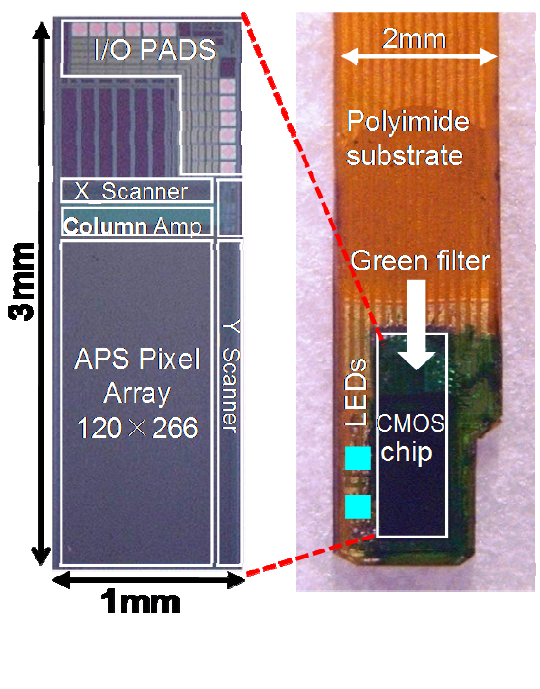
Figure 20. Microphotograph of the sensor chip and the fabricated device implanted into the brain of the freely moving mouse (adapted from [36]). The surface is coated with green filter for GFP (green fluorescence protein). Two LEDs for excitation of GFP are placed on the side of the